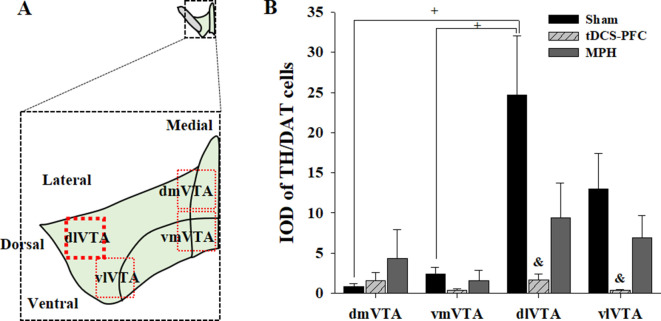
Effect of HD-tDCS application over the prefrontal cortex on the expression of TH/DAT double-positive cells in the VTA in a rat model of ADHD.(A) Illustration depicting the distribution of TH/DAT-positive cells and (B) histogram showing the mean IOD of TH/DAT-positive cells. Data are presented as the mean ± SEM. TH/DAT double-positive cells in the sham group showed higher distributions in the lateral VTA than in the medial VTA, and cell numbers in the lateral region were significantly decreased following HD-tDCS application, compared to the sham results. dmVTA, dorsomedial VTA; vmVTA, ventromedial VTA; dlVTA, dorsolateral VTA; vlVTA, ventrolateral VTA. &p<0.05 vs. sham; +p<0.05 vs. dlVTA.